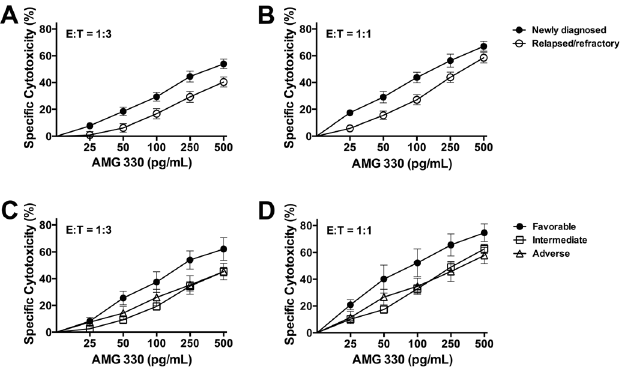
Fig 4. AMG 330-induced cytotoxicity in the presence of healthy donor T-cells, stratified by disease stage and risk. AMG 330-induced cytotoxicity at 48 hours, stratified by (A, B) disease stage (newly diagnosed AML [n = 21] and relapsed/refractory AML [n = 20]), and (C, D) cytogenetic/molecular disease risk (favorable-risk [n = 5]; intermediate-risk [n = 26]); and adverse-risk [n = 10]) in the presence of T-cells from a single healthy donor at an E:T cell ratio of 1:3 and 1:1, as